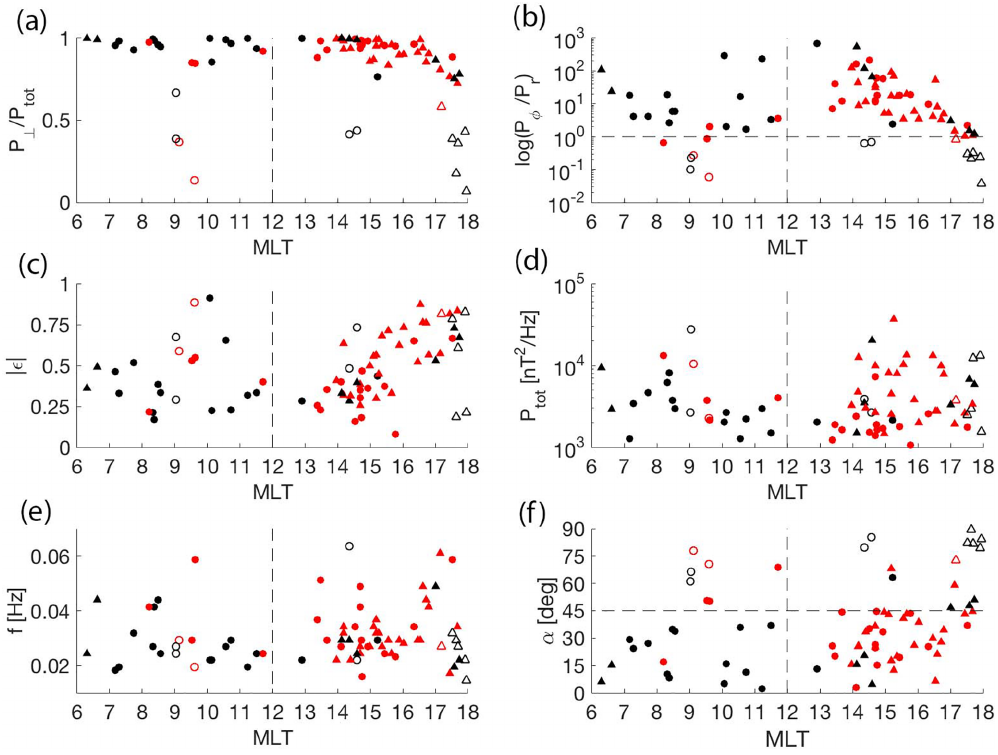
Figure 2. Results versus magnetic local time (MLT) of ULF events fulfilling the polarization analysis criteria outlined in Sect. 2. (a) Per- pendicular over total power spectral density, (b) azimuthal over radial power spectral density in log scale, (c) absolute ellipticity, (d) total power spectral density in log scale, (e) frequency, and (f) wave normal angle, all evaluated at maximum power spectral density. Red and black colors represent positive and negative ellipticity, respectively; dots and triangles represent general ULF events and KHI-ULF events, respectively; and empty symbols represent events with a low perpendicular over total power spectral density ( < 0 .